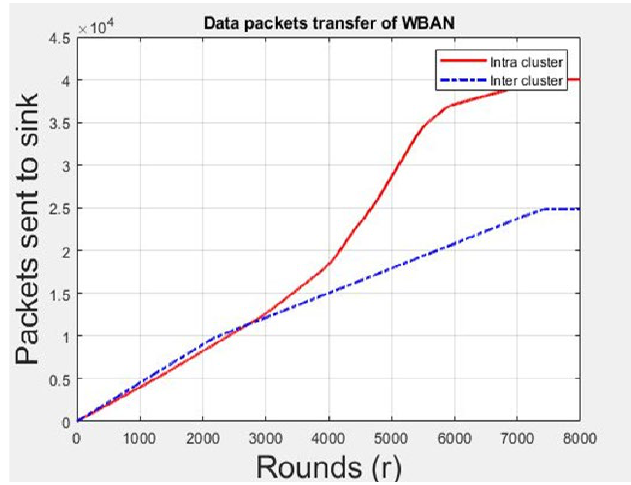
Figure 8. Data packet Transfer for WBAN